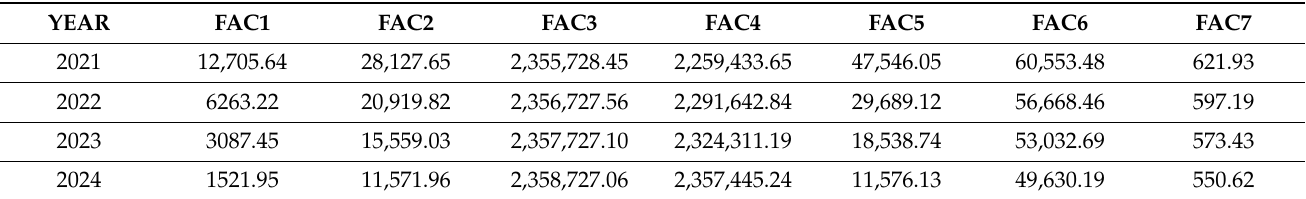
Table 16. Forecasting results